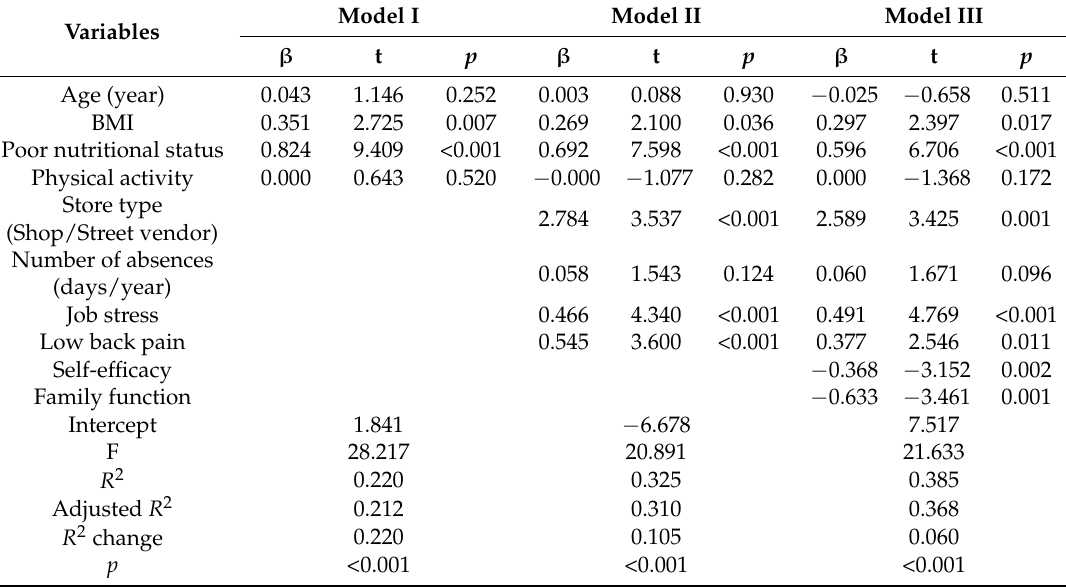
Table 3. Multiple regression analyses of selected variables on depressive symptom ( N =